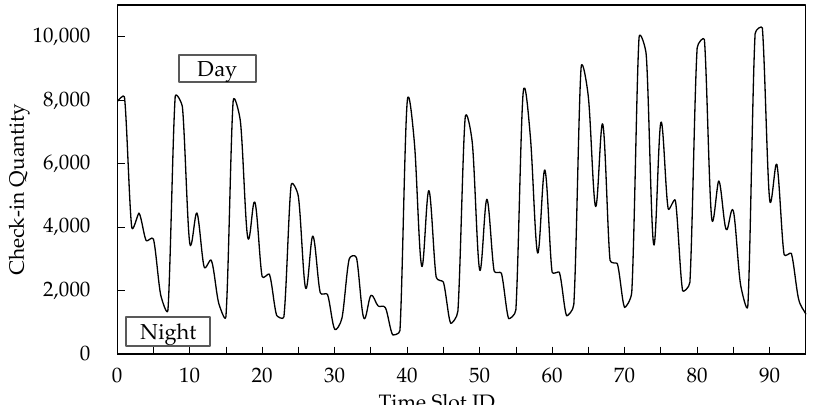
Figure 10. The distribution of check-ins for 32 time slots.